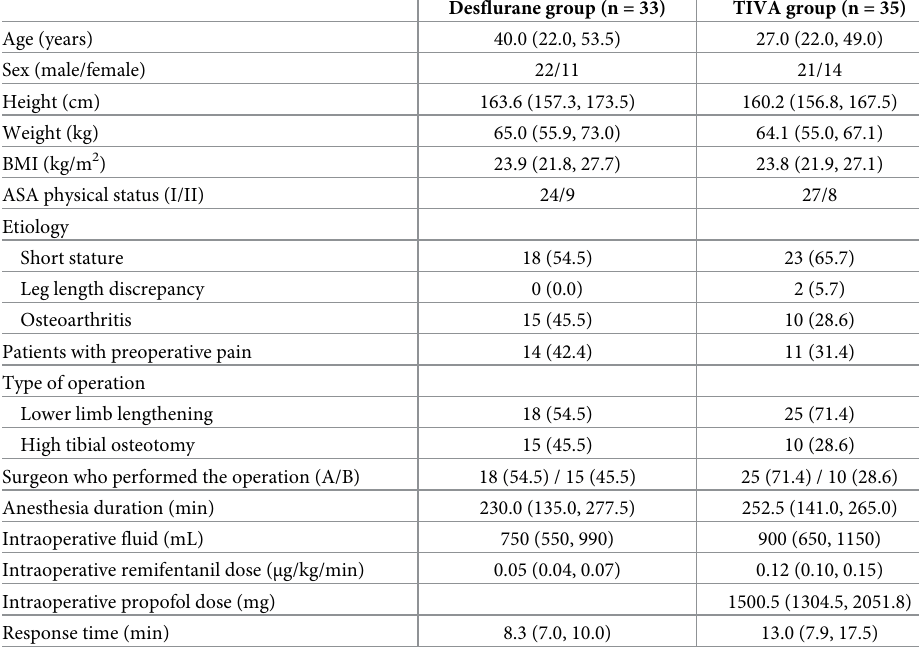
Table 1. Patient